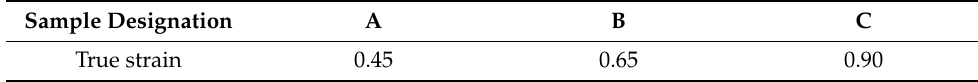
Table 2. Sample designations used in the present